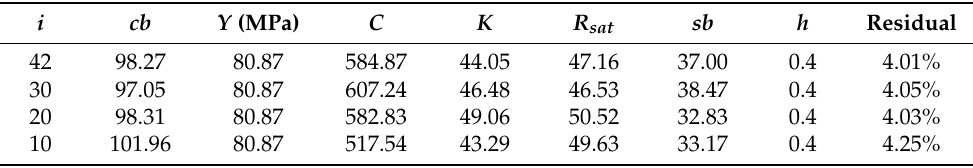
Table 5. Optimal parameters with varying particle